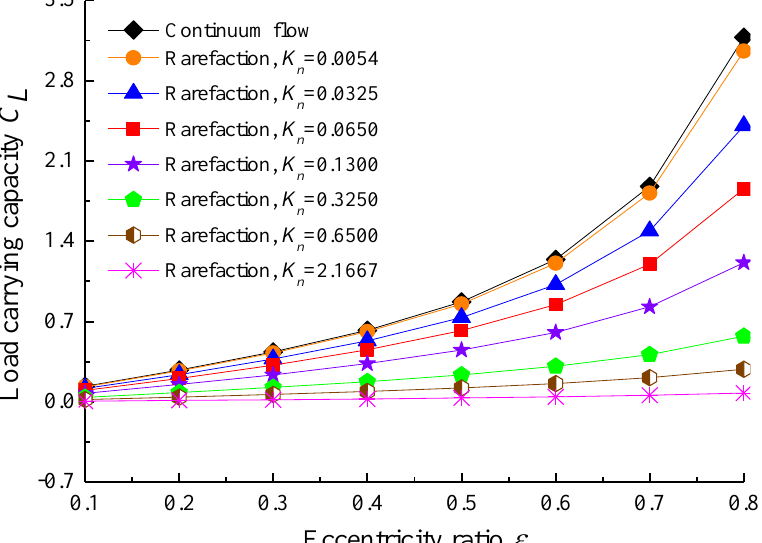
Figure 4. The load capacity of Boltzmann model versus eccentricity ratio for different Knudsen numbers ( Λ = 3, B / D = 0.5).